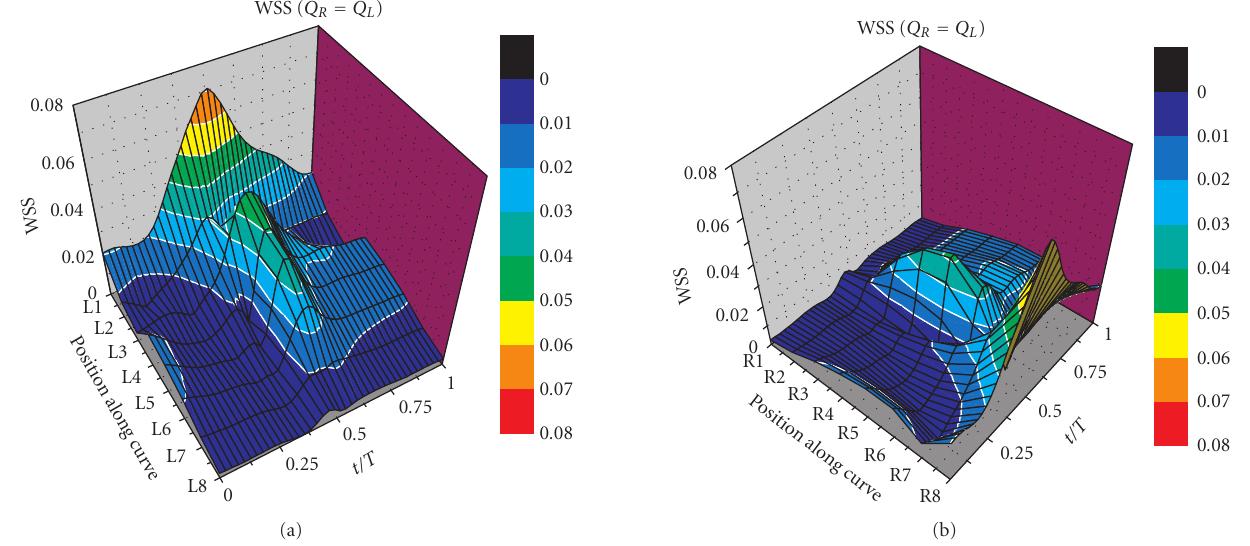
Figure 8: WSS versus position and time for Q R = Q L on (a) the left and (b) the right bifurcation regions.